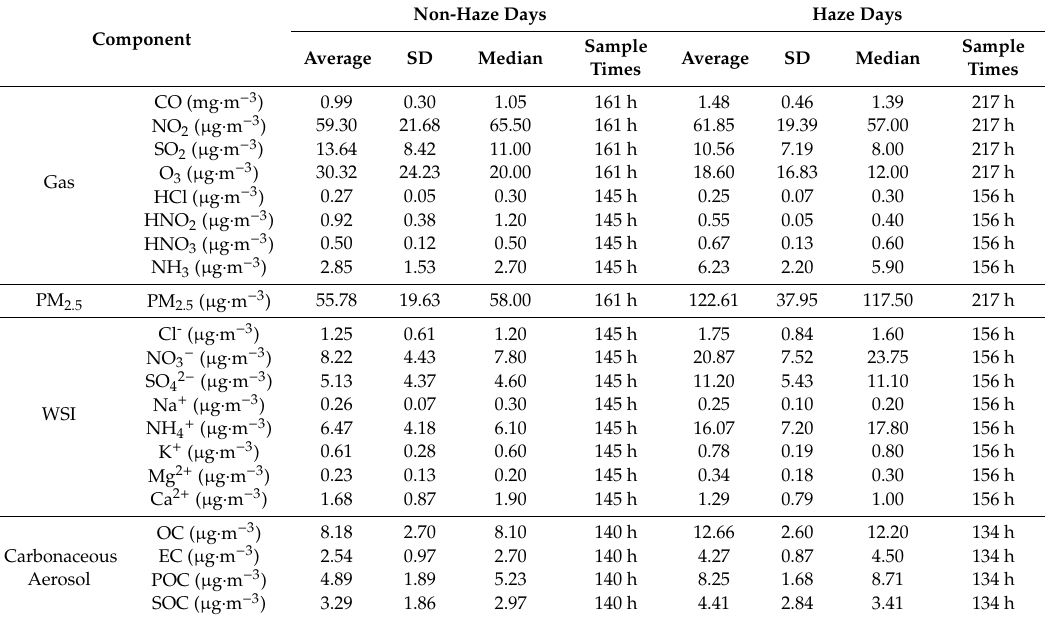
Table 1. Chemical components on haze and non-haze